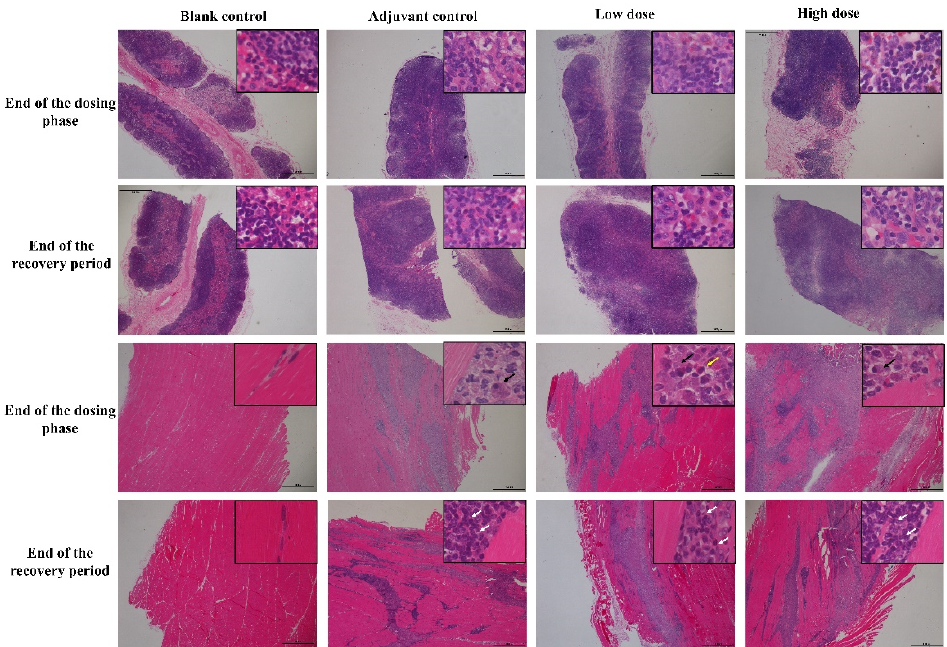
Figure 4. The histopathology changes of draining lymph nodes (inguinal lymph nodes, upper 2 rows) and muscle at injection site (lower 2 rows) in cynomolgus monkeys after 4 times repeated injections of ZF2001 vaccine. Inguinal lymph nodes and muscle staining was performed using hematoxylin and eosin (H&E, figures × 20, insets × 400). Black arrow = phagocytes, white arrow = lymphocytes, yellow arrow = eosinophils.